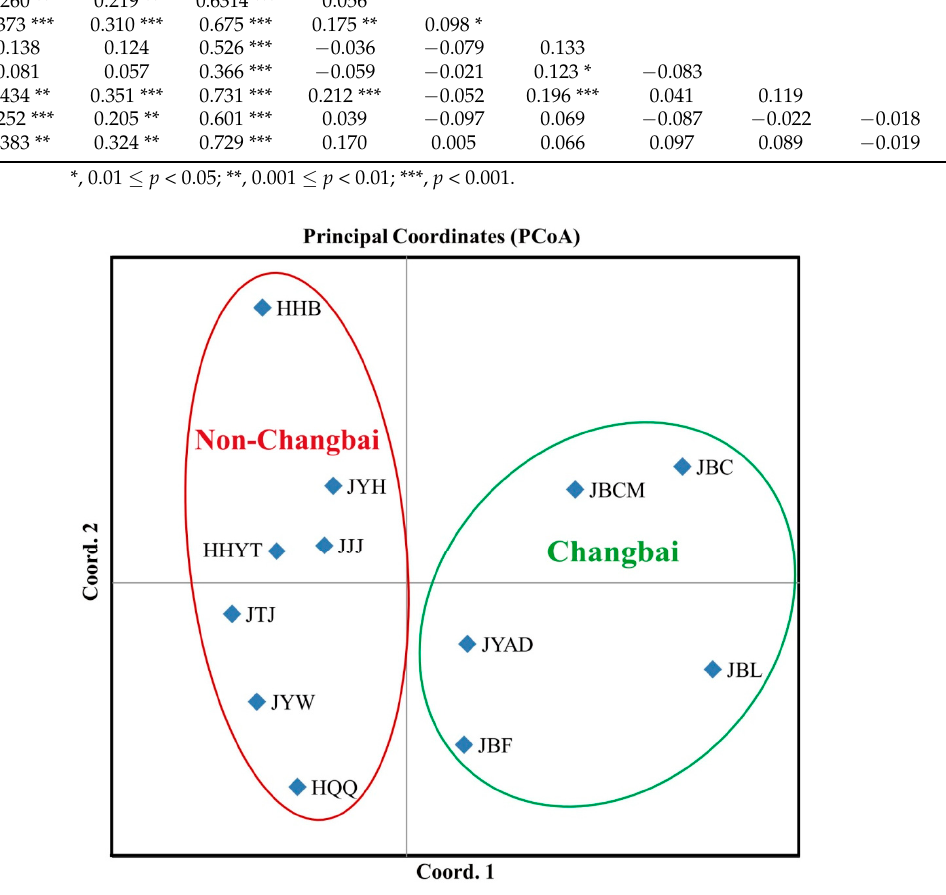
Figure 4. Principal coordinate analysis of 12 populations of Cylindrocarpon -like fungi based on Nei’s genetic distance by using GenAlEx. Axes 1 and 2 of the PCoA accounted for 85.38% and 7.05% of the total genetic variation. A green ellipse indicates all Changbai populations, and red ellipse indicates non-Changbai populations. AMOVA also revealed significant variation among geographic regions (Changbai and non-Changbai), accounting for 36% of the total genetic variation (Table 6). Among individual isolates within populations exhibited 59% of the genetic variation, while only 5% of the genetic variation was attributed to variations among populations. All the sources of variation were significant ( p = 0.01). Table 6. Analysis of molecular variance (AMOVA) within and among 12 populations of Cylindro- carpon -like fungi.